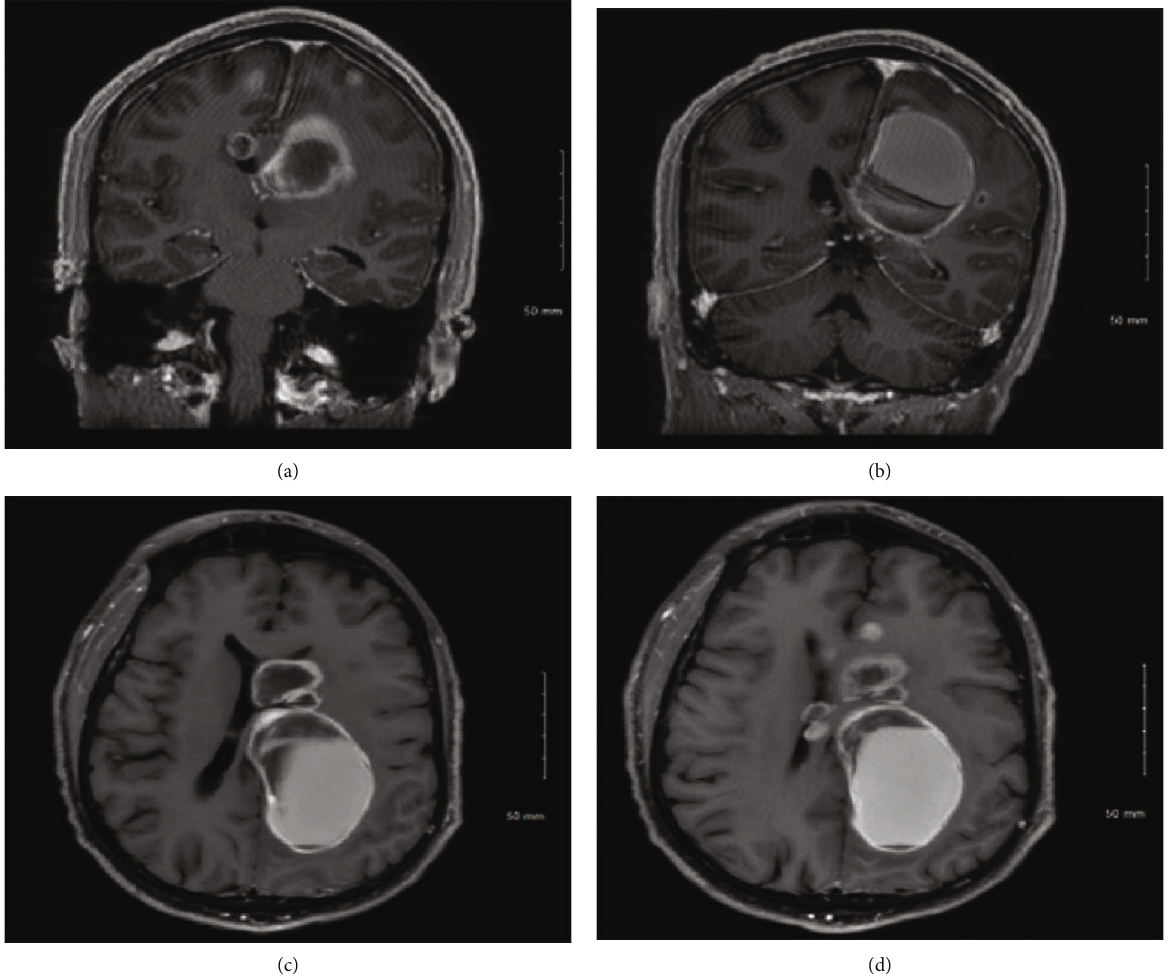
Figure 1: MRI images of the patient ’ s brain. (a, b) T1 postcontrast coronal sequences of the brain showing multiple cystic lesions of varying sizes in the cerebral hemispheres. (c, d) T1 postcontrast axial sequences of the brain showing multiple cystic lesions of varying sizes in the cerebral